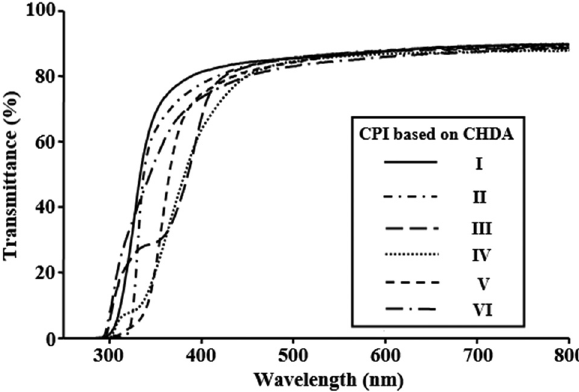
Figure 8: UV - Vis transmittance of various CPI fi lms obtained from the CHDA monomer.